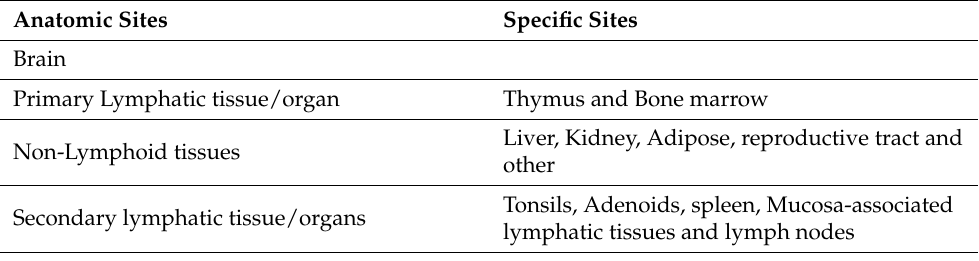
Table 1. The different anatomical sites that harbor latent HIV provirus